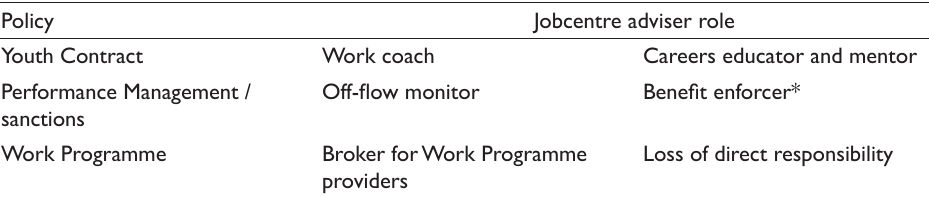
Table 1: Jobcentre adviser